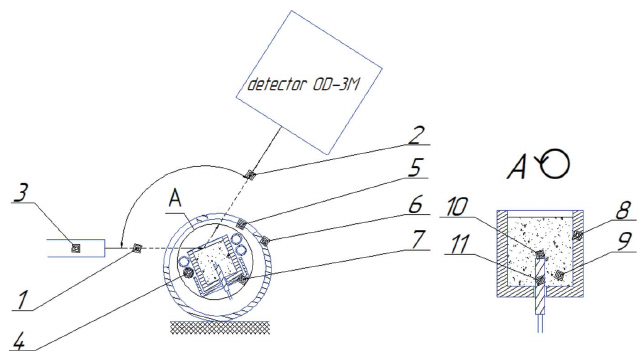
Figure 3 Scheme of the experimental setup: 1 – incident synchrotron radiation beam; 2 – reflected synchrotron radiation beam; 3 – emitter; 4 – inductor spiral; 5 – beryllium window; 6 – vacuum chamber; 7 – crucible holder; 8 – crucible; 9 – powder reagents; 10 – thermocouple; 11 –